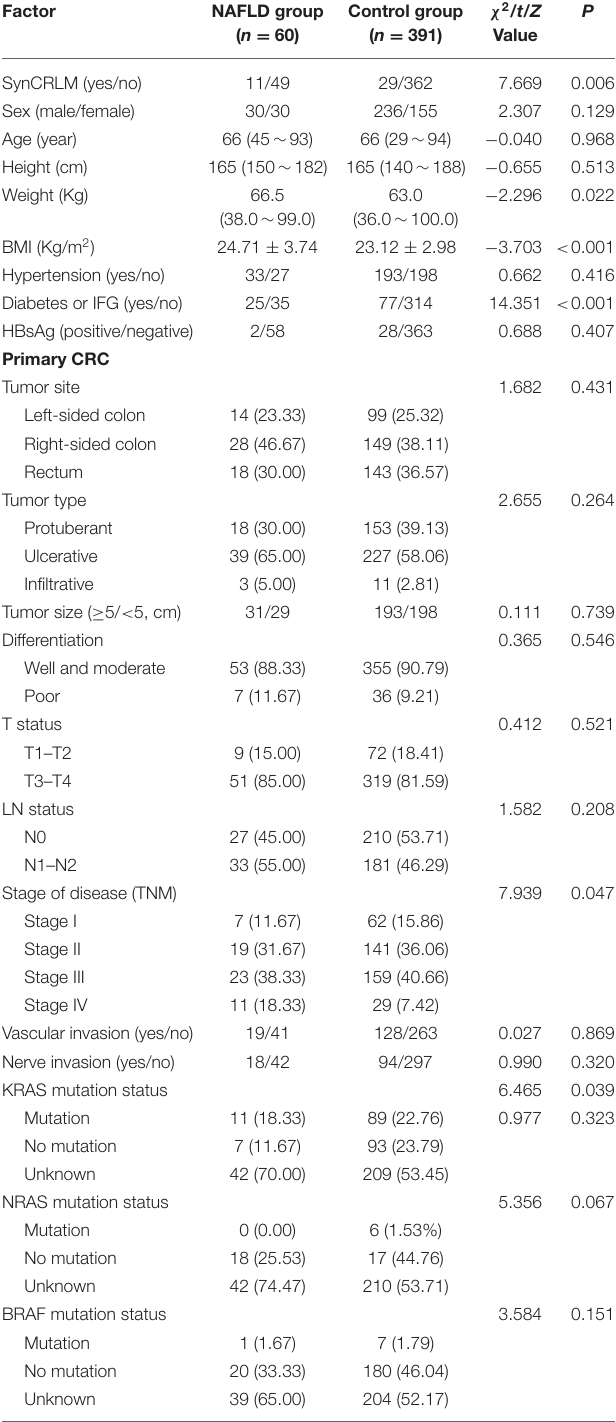
TABLE 1 | Clinicopathological parameters of primary colorectal cancer in the NAFLD group and control